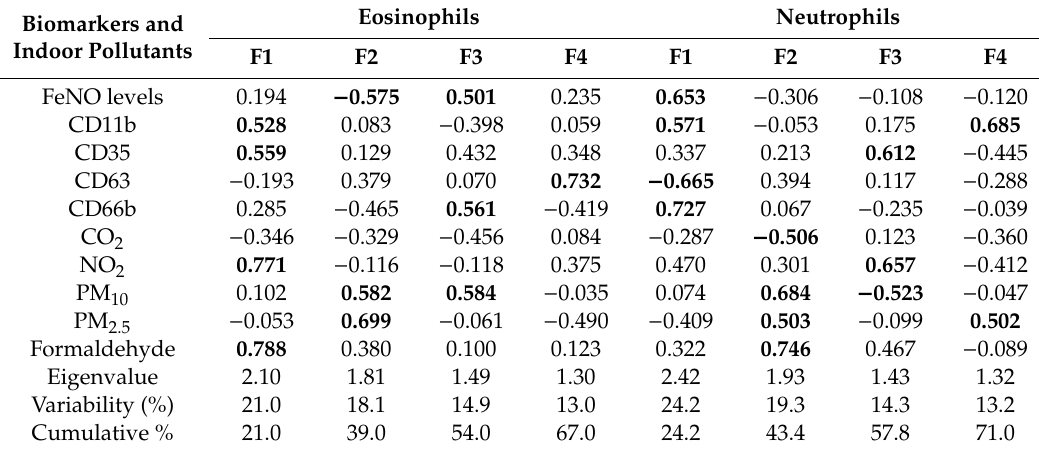
Table 3. Factor loadings using PCA for eosinophils and eosinophils. The moderate (0.5–0.75) and strong ( > 0.75) factor loadings are highlighted in